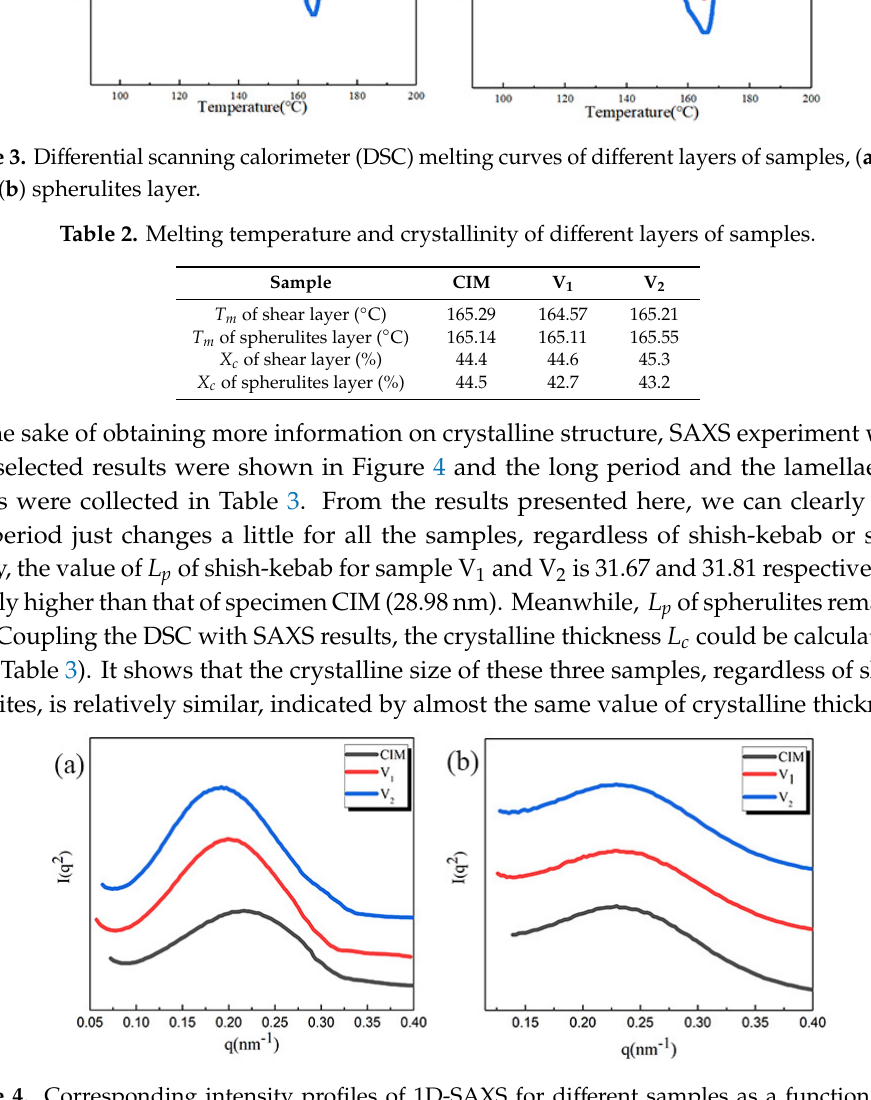
Figure 4. Corresponding intensity profiles of 1D ‐ SAXS for different samples as a function of the scattering vector (q): ( a ) shear layer; ( b ) spherulites layer. Table 3. Value of long period and crystalline size of different layers of samples. Sample